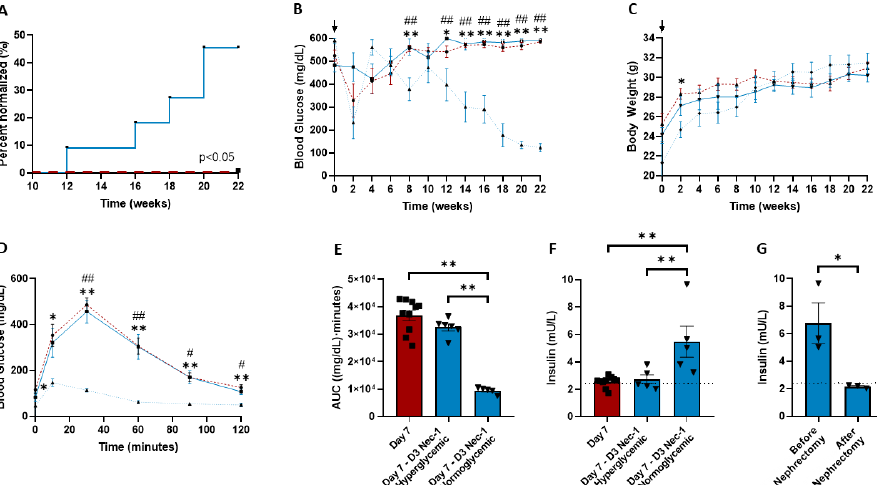
Figure 7. Long-term metabolic follow-up of diabetic athymic nude mice after islet transplantation with PPIs cultured for 7 days in control media ( n = 10, dash red line) or media supplemented with Nec-1 on day 3 of tissue culture (hyperglycemic mice: n = 6, solid blue line; normoglycemic mice: n = 5, dotted blue line). Athymic nude mice were rendered diabetic by an intraperitoneal streptozotocin injection, transplanted with 5000 IEQs of PPIs under the kidney capsule, and followed for 22 weeks. ( A ) Percentage of mice achieving normoglycemia (blood glucose < 200 mg/dL for 2 consecutive weeks) after islet transplantation from week 10 to 22. ( B ) Average weekly non-fasting blood glucose measurements from 0 to 22 weeks after islet transplantation. ( C ) Average weekly body weight measurements from 0 to 22 weeks after islet transplantation. ( D ) Blood glucose measurements during an OGTT (3 mg/kg) at 22 weeks after islet transplantation. ( E ) Glucose clearance after an OGTT (3 mg/kg) at 22 weeks post-transplantation expressed as AUC. ( F ) Porcine insulin measurements in serum of mice at 22 weeks after islet transplantation. ( G ) Porcine insulin measurements in serum of normalized mice ( n = 3) before and after nephrectomy of the graft-bearing kidneys at 22 weeks post-transplantation with islets cultured in media supplemented with Nec-1 on day 3 of tissue culture for 7 days. Downward arrows indicate time of implantation of an insulin pellet. Dotted black lines indicate the lower limit of the assay range (2.3 mU/L). * p < 0.05 (Day 7 vs. Day 7-D3 Nec-1-Normoglycemic). ** p < 0.01 (Day 7 vs. Day 7-D3 Nec-1-Normoglycemic). # p < 0.05 (Day 7-D3 Nec-1-Hyperglycemic vs. Day 7-D3 Nec-1-Normoglycemic). ## p < 0.01 (Day 7-D3 Nec-1-Hyperglycemic vs. Day 7-D3 Nec-1-Normoglycemic). Data expressed as mean ± SEM. Individual data points for islets cultured in control media (Day 7) or media supplemented with Nec-1 on day 3 of tissue culture (D3 Nec-1) are shown within each bar graph as either squares, inverted triangles,